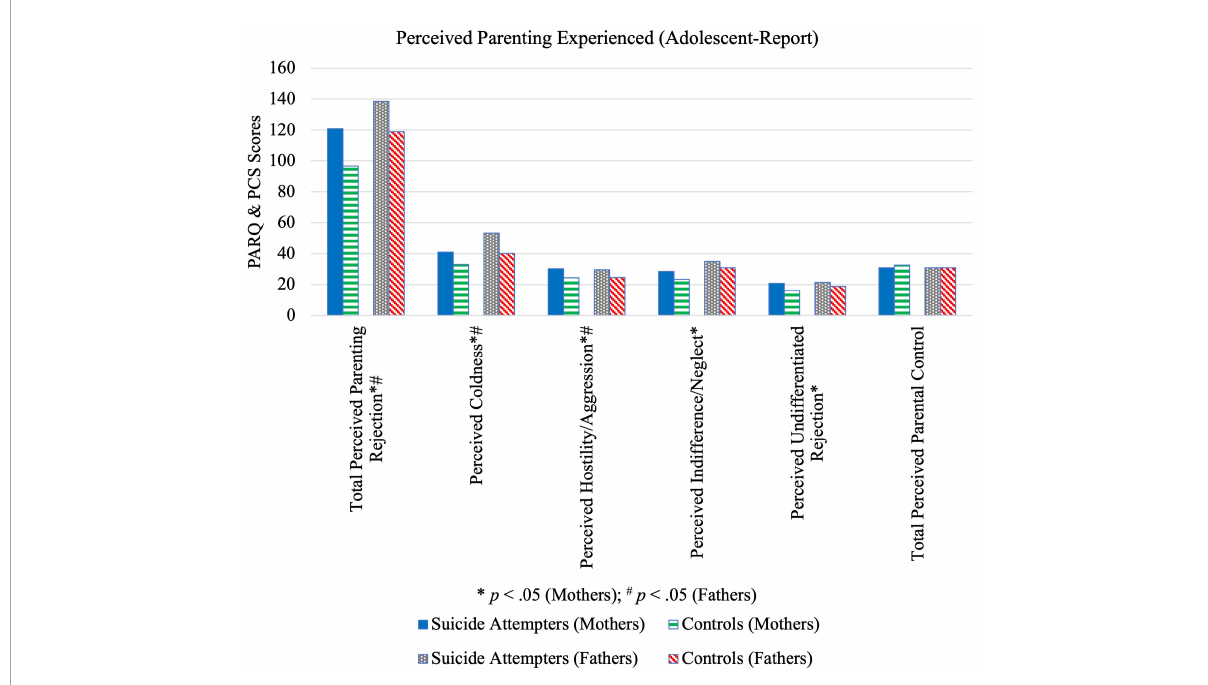
FIGURE3 Illustration of differences in perceived parenting experienced reported by suicide attempters and control group